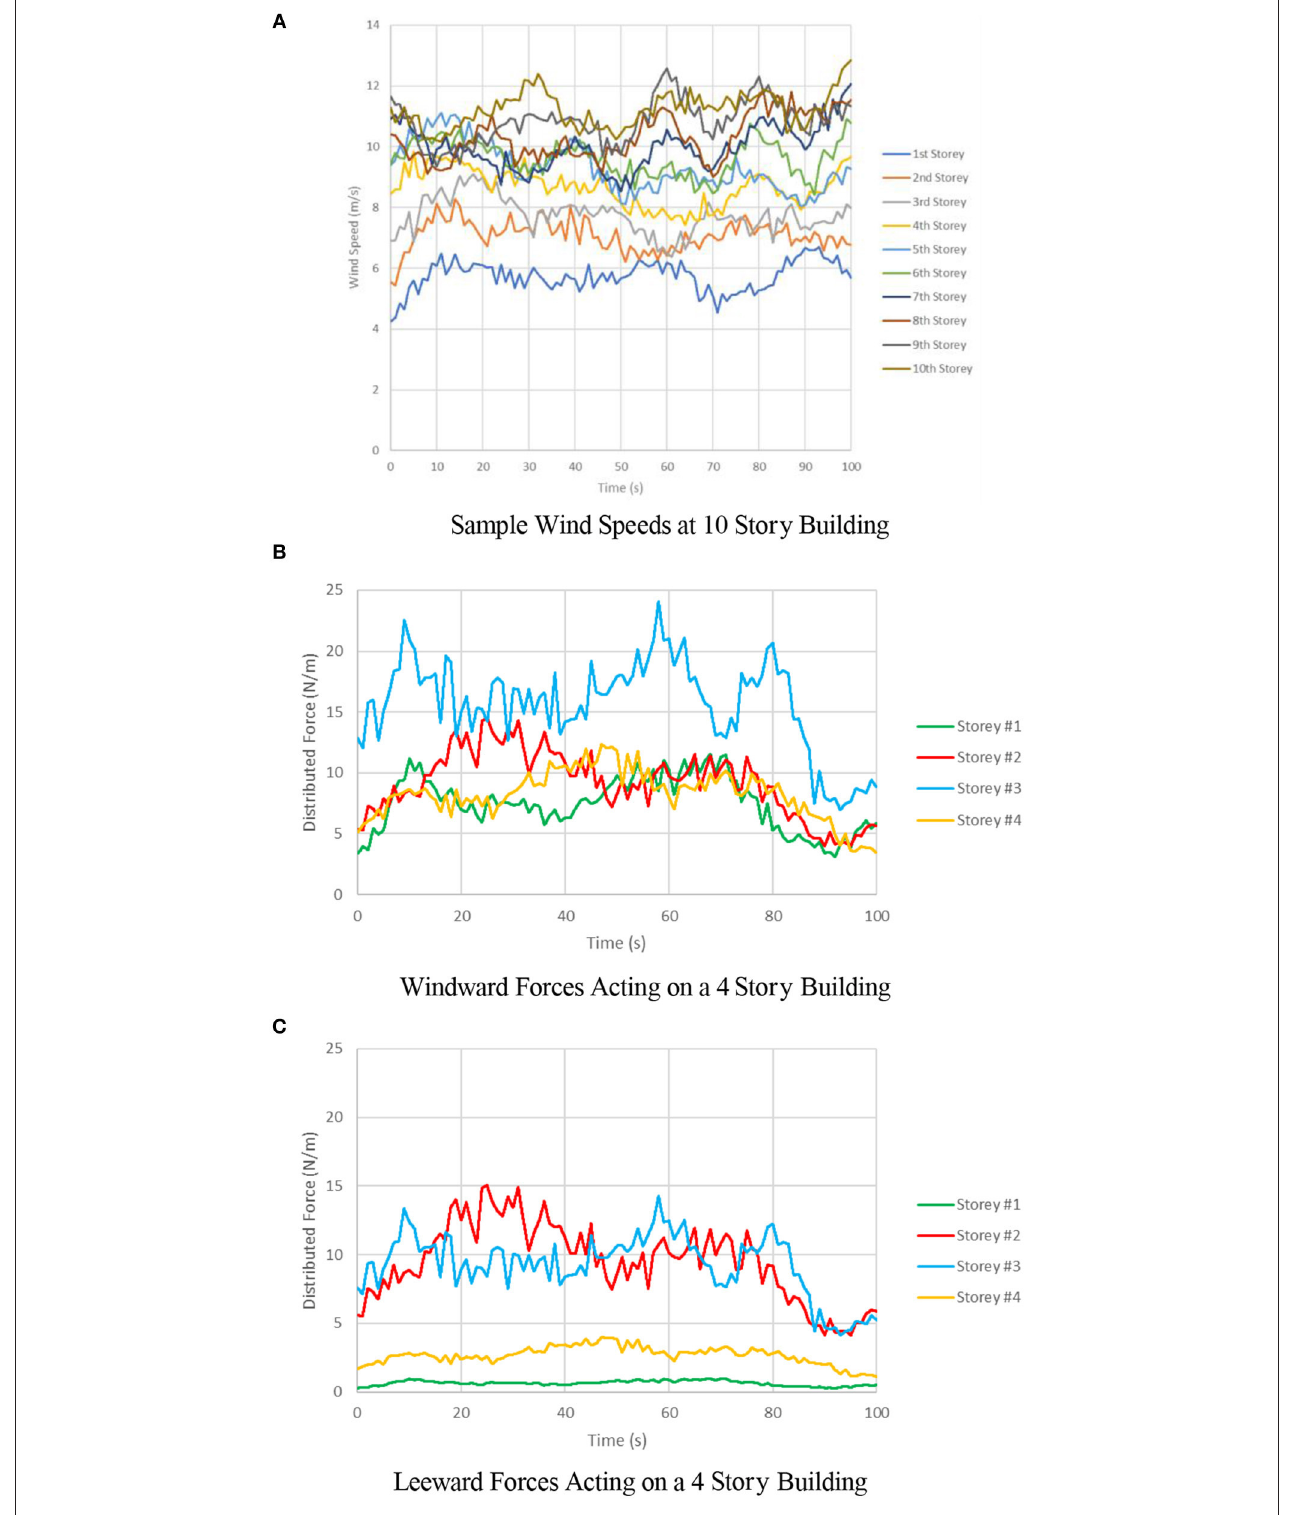
FIGURE 2 | Sample wind forces. (A) Sample wind speeds at 10 Story building. (B) Windward forces acting on a 4 Story building. (C) Leeward forces acting on a 4 Story building.